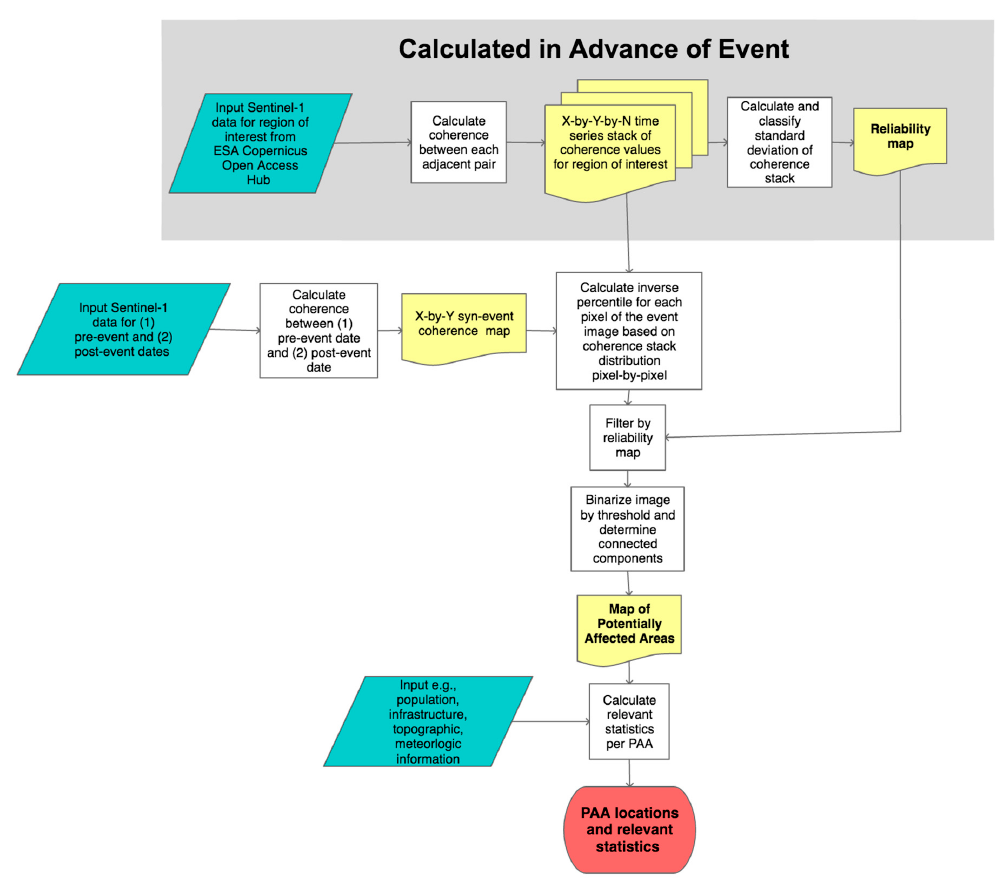
Figure 1. Diagram illustrating the workflow of the potentially affected area (PAA) detection. Data input is denoted by blue parallelograms; processes are shown as white rectangles, algorithm-generated geotiffs are shown as yellow documents; and the output PAA locations and statistics are shown in the red terminal rectangle. The generation of the coherence database and the reliability map can be completed before an event has occurred (left hand of flow chart). After an event has occurred, the pre- and post-event SAR images can be input into the algorithm, as well as any pertinent additional information (e.g., population count, infrastructure, resources), to detect and characterise PAAs.